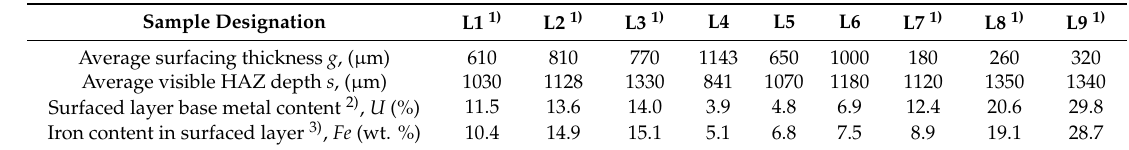
Table 9. The average thickness of the coating layers, iron content in the coating layers and HAZ width for samples obtained in the process of laser surfacing, Table 7.